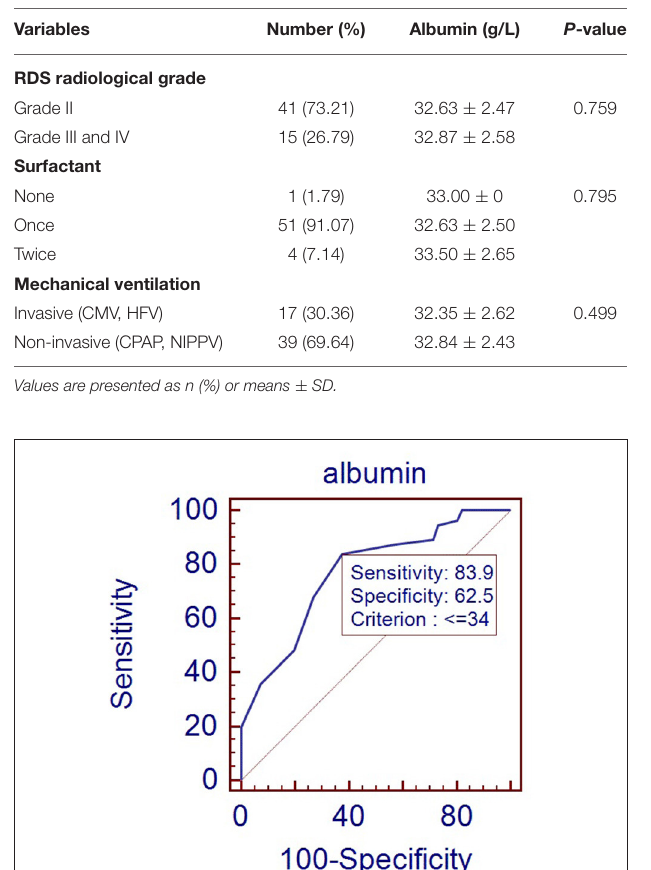
was 0.77. Using the albumin cutoff level of 34 g/L provides a sensitivity of 83.9% with a specificity of